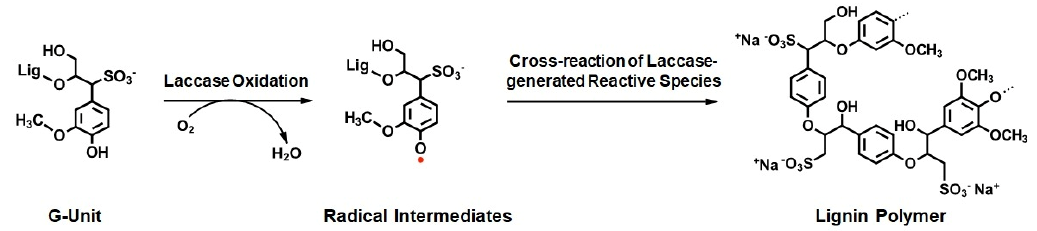
Figure 7. Reaction mechanism of laccase catalyzed polymerization of lignosulfonate [150].